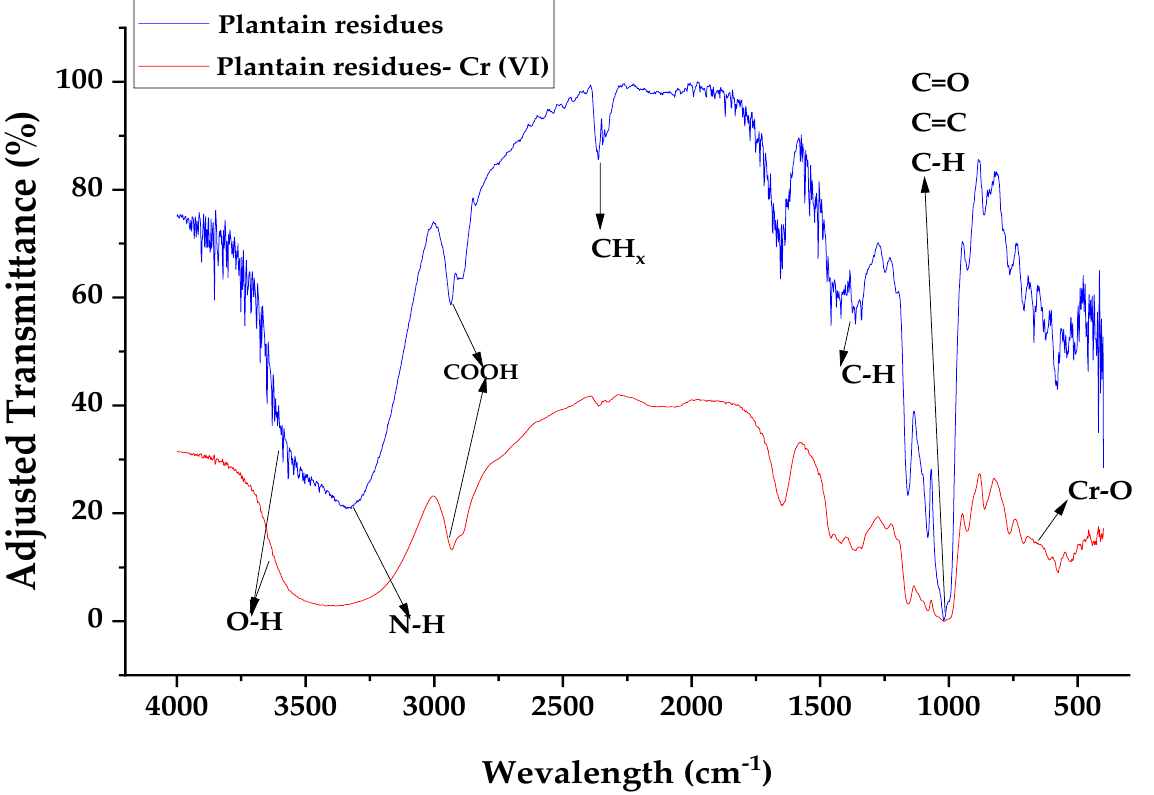
Figure 1. Normalized IR spectrum of plantain residues before (blue) and after (red) Cr (VI) adsorp- tion.